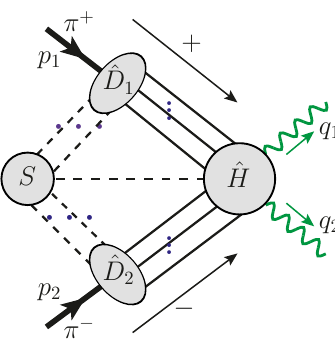
Figure 4. General reduced diagram for the scattering amplitude of exclusive annihilation process for π + π − → γγ . Both dashed and solid lines can represent quarks and/or